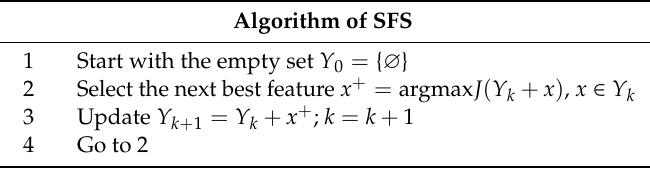
Table 4. Sequential-backward-selection (SFS) procedure.